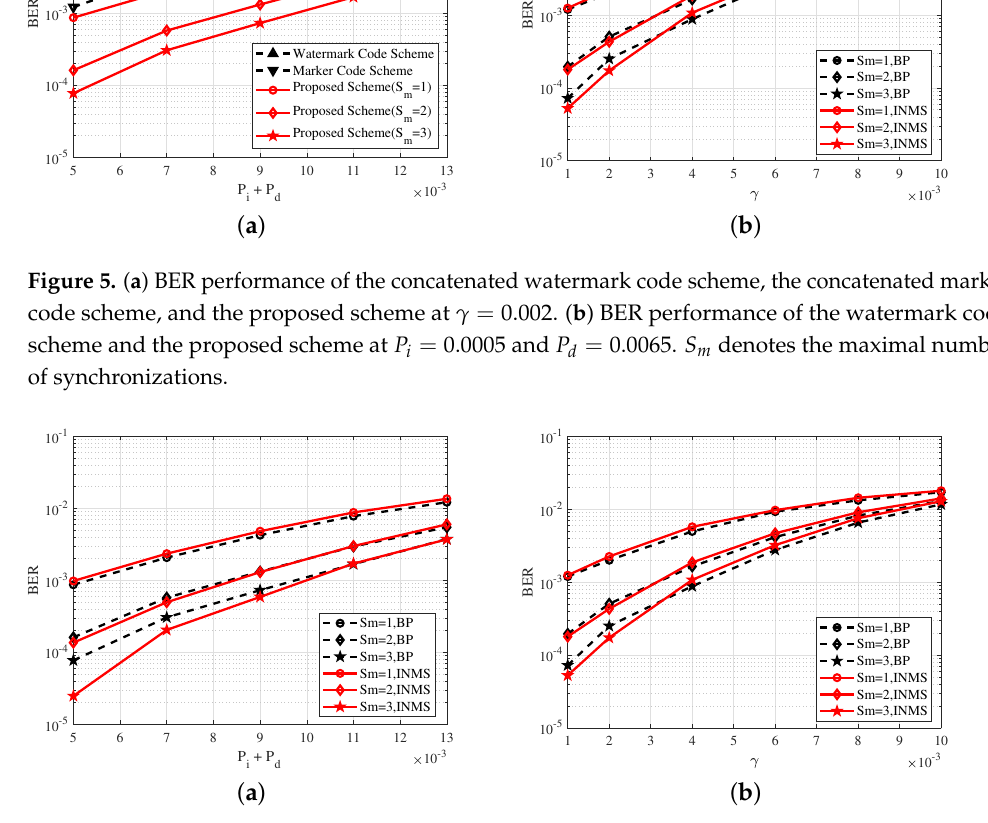
Figure 6. ( a ) BER performance of the INMS and BP algorithms at γ = 0.002. ( b ) BER performance of the INMS and BP algorithms at P i = 0.0005 and P d = 0.0065. The S m denotes the maximal number of